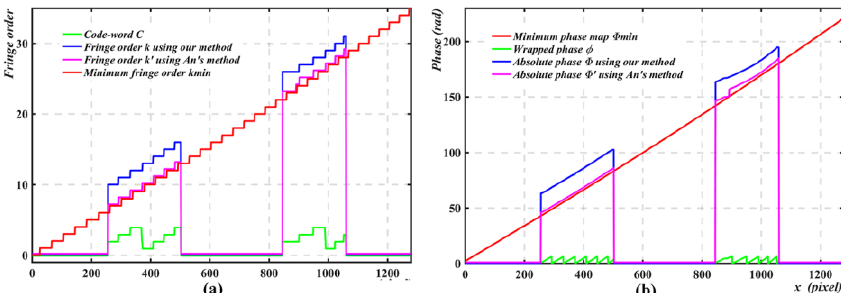
Figure 12. The 600th rows. ( a ) Fringe order maps; ( b ) absolute phase maps.